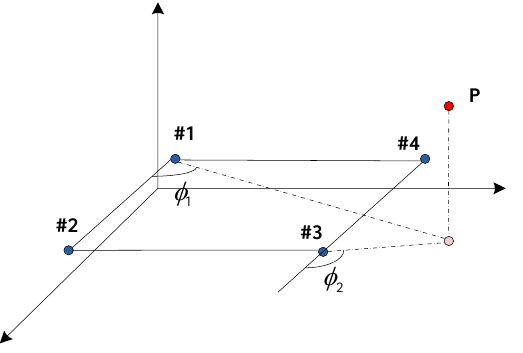
Figure 2. Coordinates of the PD source and antenna array. #1–#4 are the antennas #1–#4. To simulate the real situation, the starting time t 01 of the PD waveform received by antenna #1 is generated randomly. The time-domain waveform received by the antenna array is shown in Figure 3a. The simulated signals are mixed with Gaussian white noise under different SNRs and narrow-band noise with three different frequencies. The frequencies are 80 MHz, 100 MHz, and 150 MHz, and the corresponding amplitudes are 0.05 V, 0.2 V, and 0.5 V, respectively. Figure 3b shows the received PD signals with − 20 dB Gaussian white noise and narrow-band noise. Frequency analyses of the simulated PD signal with and without noise are shown in Figure 4a,b, respectively.